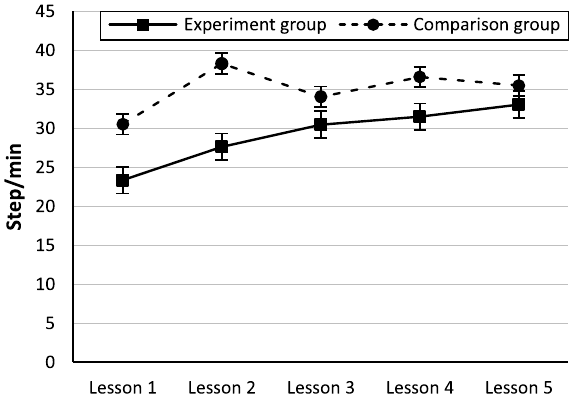
Figure 2. Step/min during the lessons.